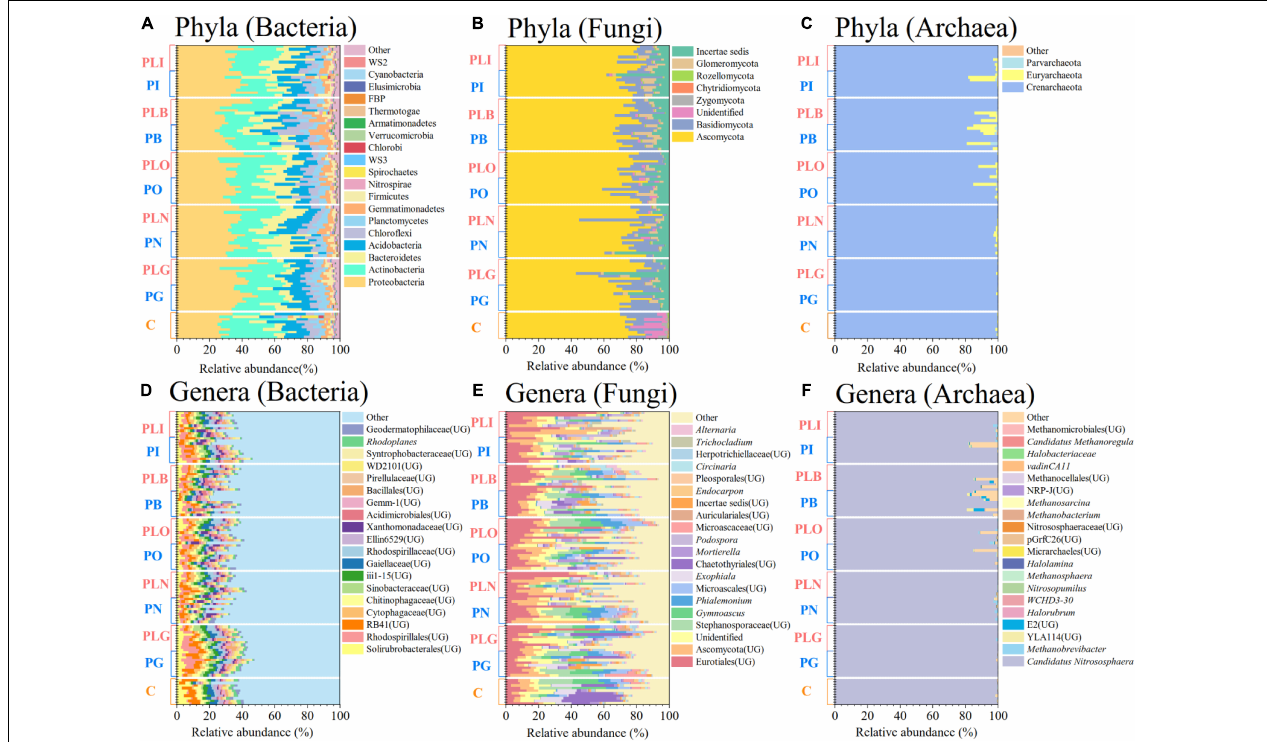
FIGURE 1 | The compositions of soil bacterial (A,D) , fungal (B,E) , and archaeal (C,F) communities at the phylum (top) and genus (bottom) level. Only dominant genera with the top 20 mean relative abundance were shown. UG, unidentified genus; C, natural grass; P, pika disturbance; PL, grazing and pika disturbance; G, grassland; N, new mound; O, old mound; B, bare land; I, inside the